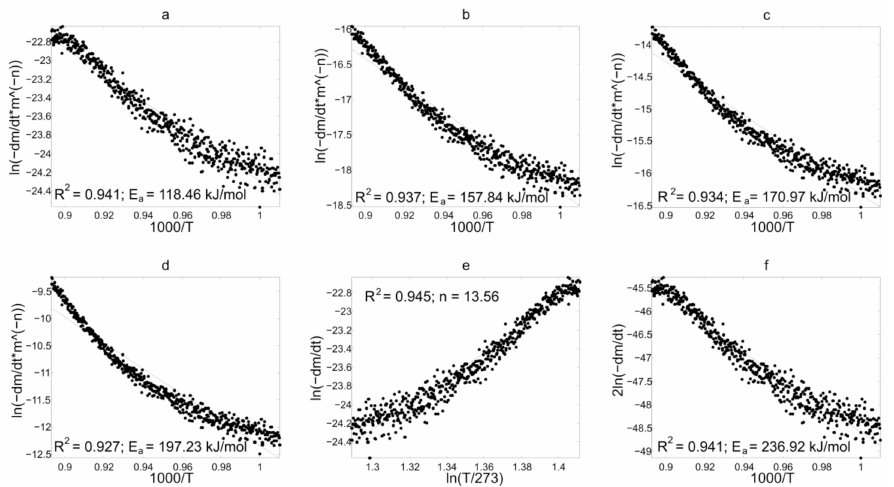
Figure 6. Results of processing of charcoal gasification TG curve at a heating rate of 1 K min − 1 by different models: ( a ) n = 0; ( b ) n = 0.5; ( c ) n = 2/3; ( d ) n = 1; ( e ) diffusion model; ( f ) pore- diffusion